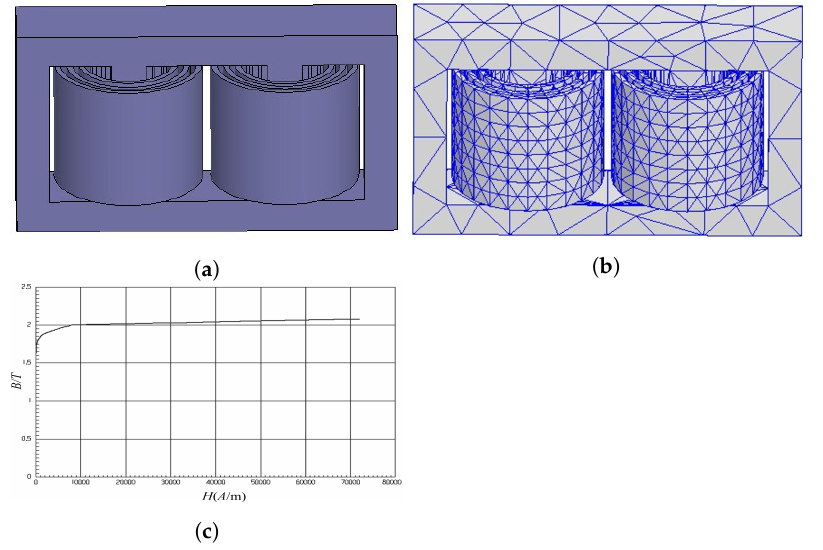
Figure 4. Finite element model of single-phase converter transformer. ( a ) Geometric model. ( b ) Sub- division model. ( c ) Magnetization curve of silicon steel